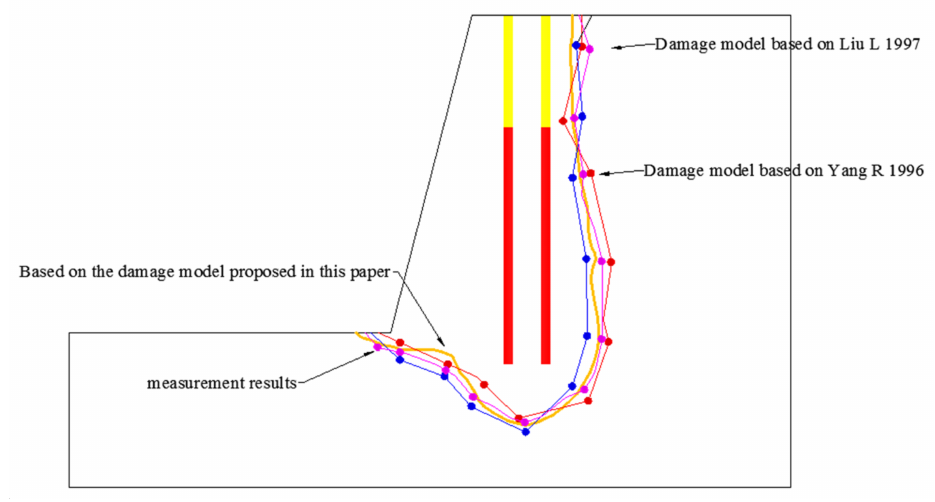
Figure 4. Comparison of numerical results and measured results of blasting rupture range [9,13].